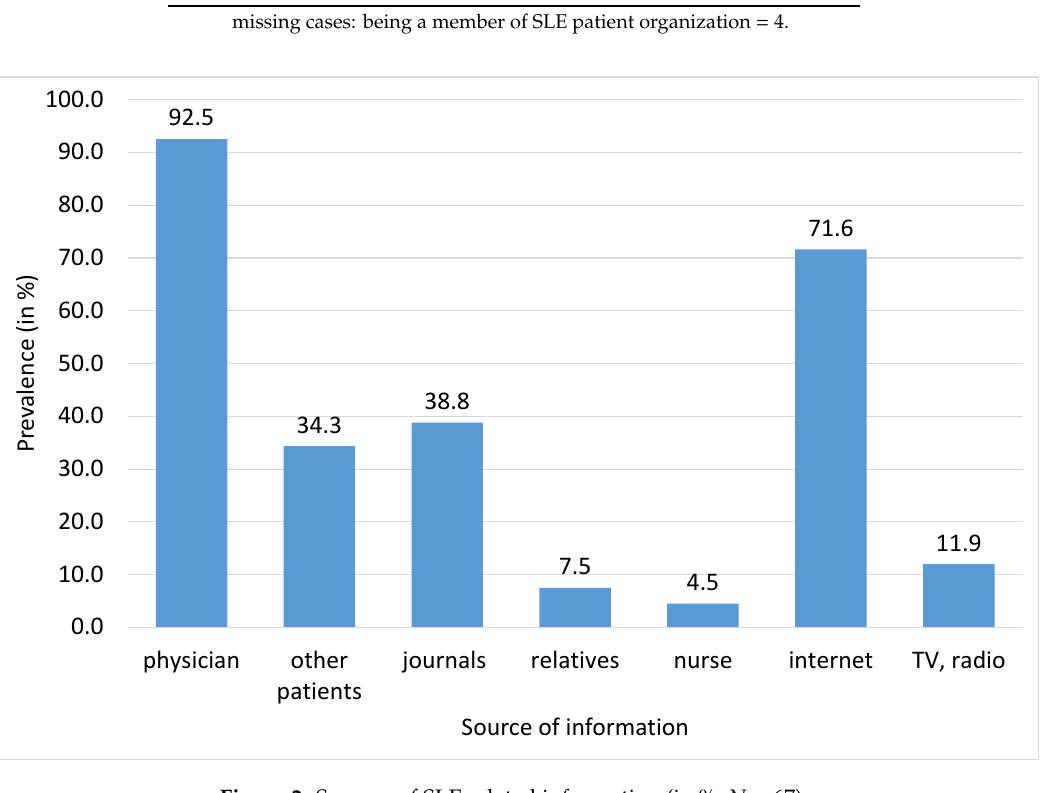
Figure 2. Sources of SLE related information (in %, N = 67).